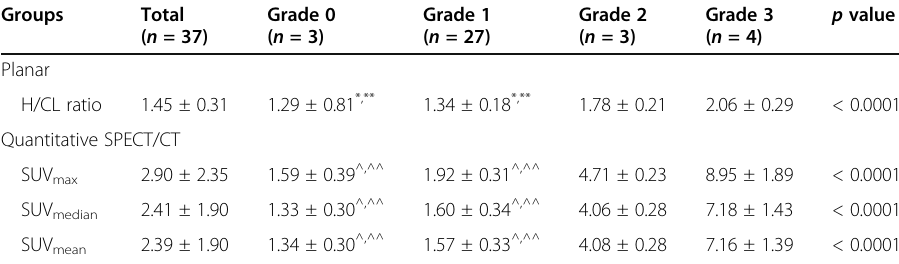
Table 3 99m Tc-PYP findings from planar and quantitative SPECT/CT images for groups divided by Perugini visual